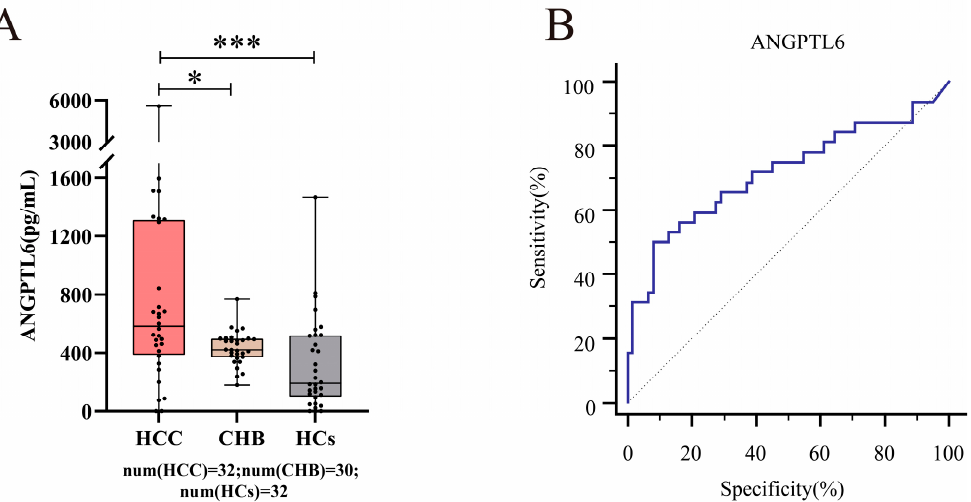
Figure 12 . The potential value of serum ANGPTL6 for the diagnosis of early HCC patients with normal serum AFP levels (AFP ≤ 7 ng/mL). ( A ) Serum ANGPTL6 levels were higher in early HCC patients with normal serum AFP levels (n = 32) than in CHB patients with normal serum AFP levels (n = 30) (p = 0.013). Serum ANGPTL6 levels were higher in early HCC patients with normal serum AFP levels (n = 32) than in HCs (n = 32) (p = 0.001). ( B ) A ROC curve of the serum ANGPTL6 levels was used to distinguish between early HCC patients with normal serum AFP levels and the noncancer group (CHB patients and HCs). * p < 0.05. *** p ≤ 0.001.